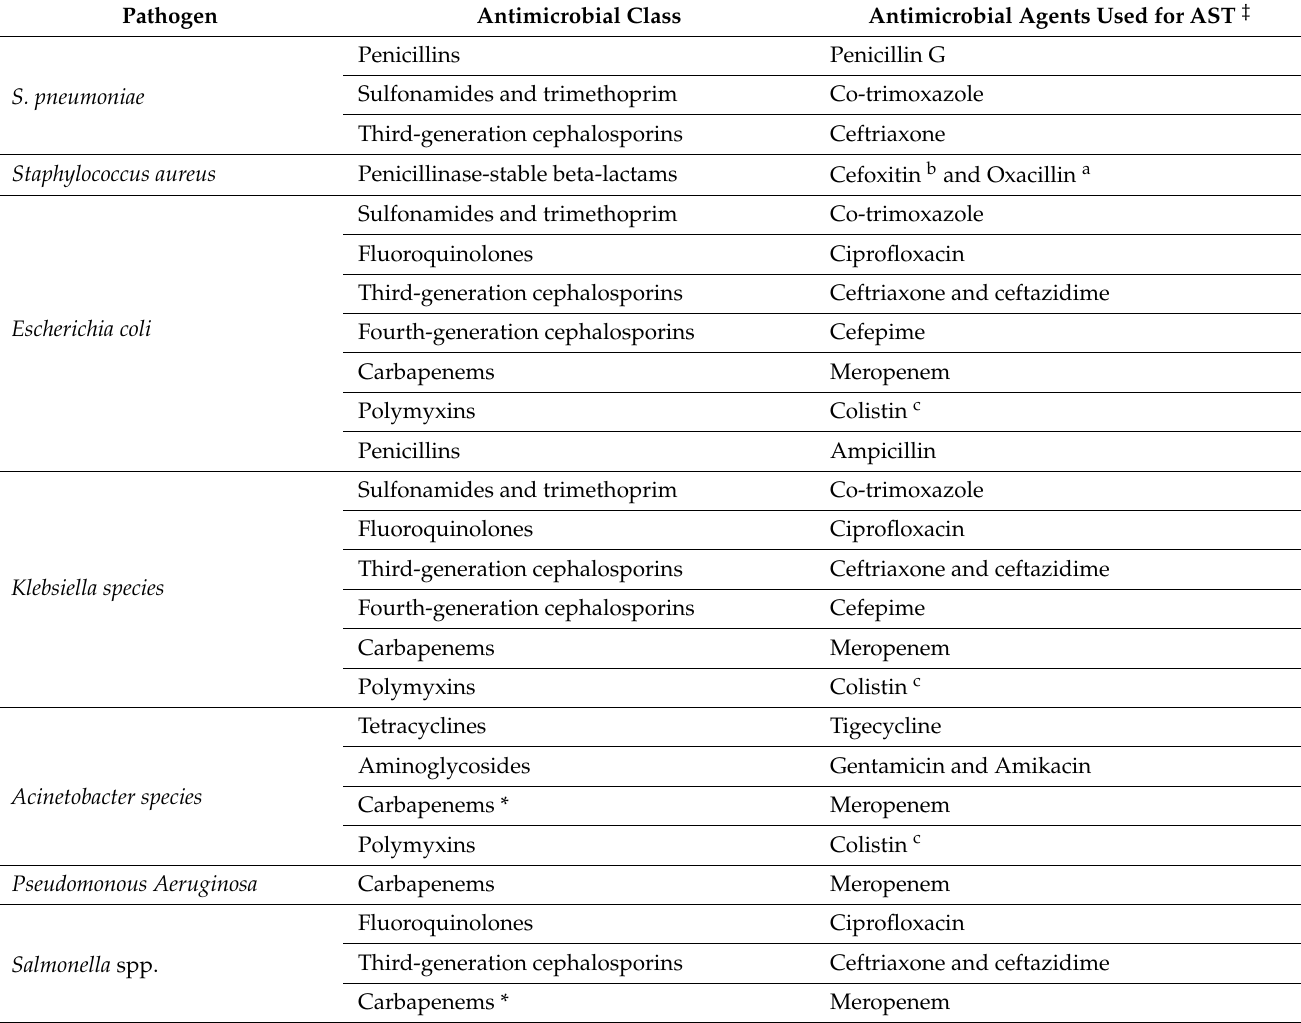
Table A1. Pathogen–antimicrobial combinations for national AMR surveillance (GLASS).